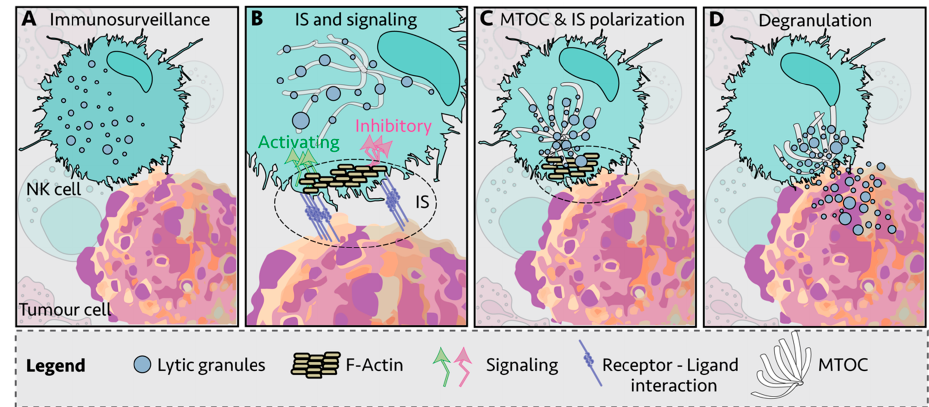
Figure 1. Immunological synapse (IS) of Natural Killer (NK) cell and target cell. ( A ) NK cells engage other cells via integrins and adhesion molecules, which create the immunological synapse (IS)—the subsequent process between engagement and killing or tolerance can be broken down into four steps.